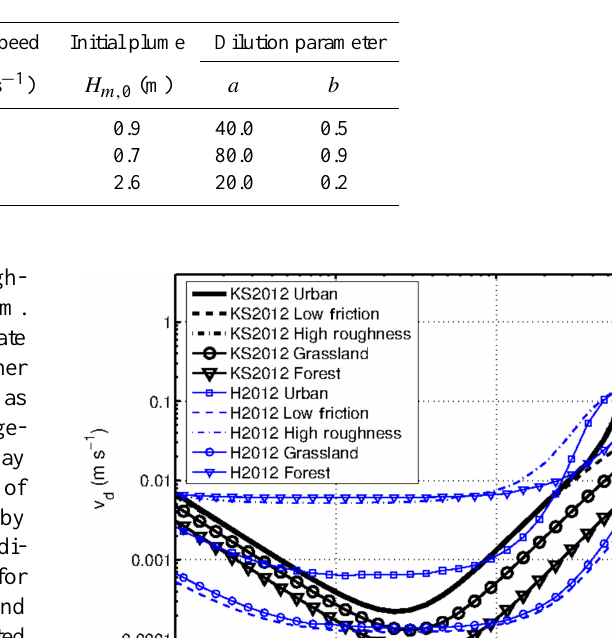
Table 1. Meteorological and dilution parameters used in the numerical computations on the evolution of the particle size distribution and PN between roadside and neighborhood timescales. Notation: U = wind speed at a height of 10m, H m = initial plume height at the roadside station, a , b = parameters of the particle dilution parameterization ( y = a × x − b , where x is the distance from roadside in meters). The moderate dispersion conditions were used for the reference case.